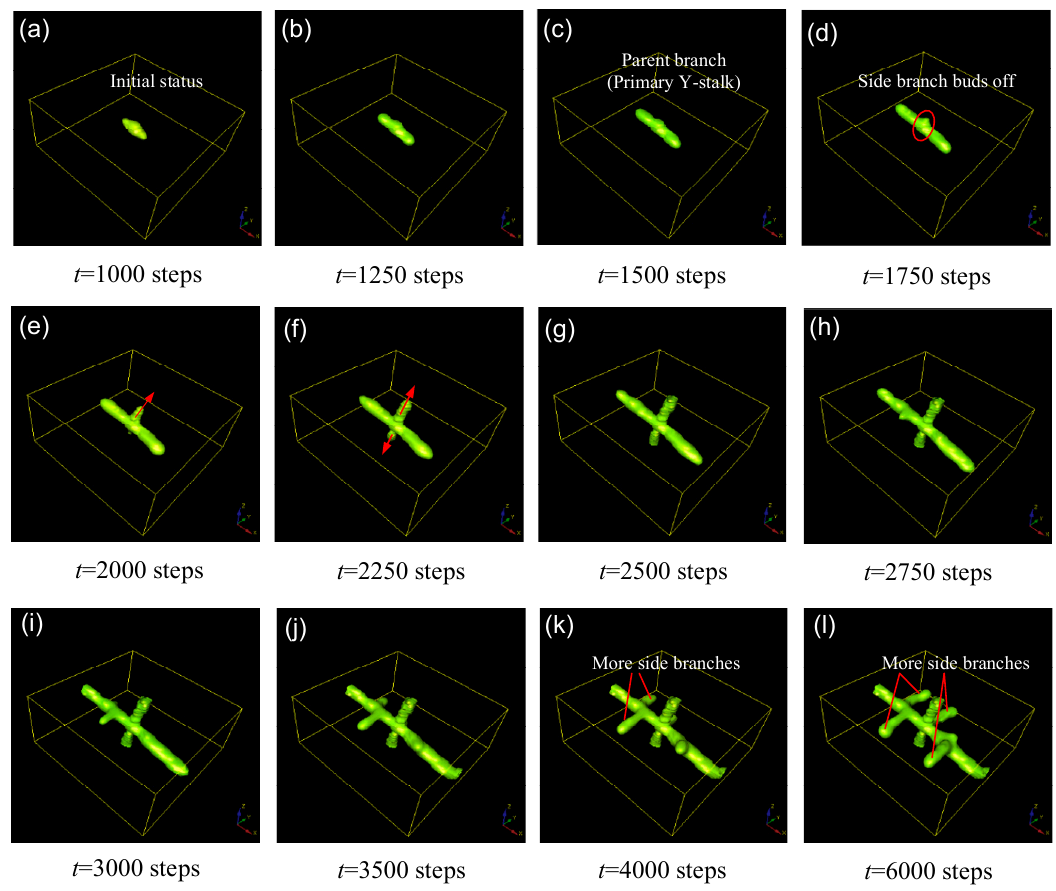
Figure 2. Simulation results for side-branching behaviors in 3D. The presented structure is the spatial distribution of the cellular differentiation marker Y . The numbers under the images denote the step number in the simulation. Parameters: c = 0.04, µ = 0.38, v = 0.04, ρ A = 0.03, ρ H = 0.0001, c 0 = 0.02, γ = 0.03, ε = 0.042, d = 0.008, e = 0.1, f = 10, D A = 0.1, D H = 0.26, D S = 0.06.